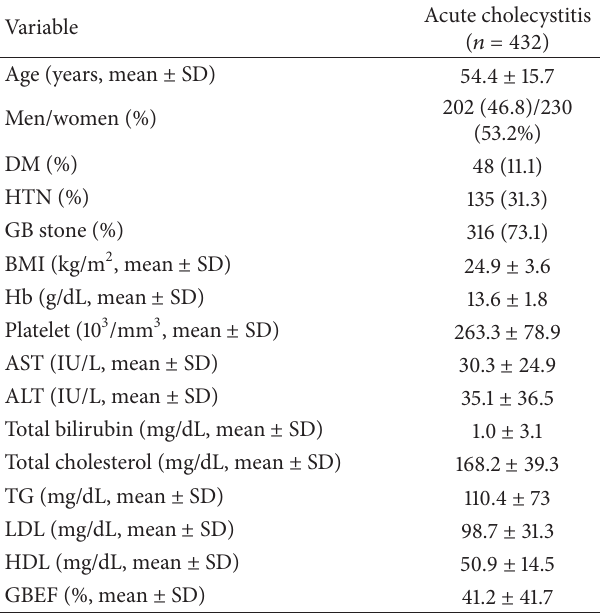
Table 1: Clinical characteristics of total enrolled